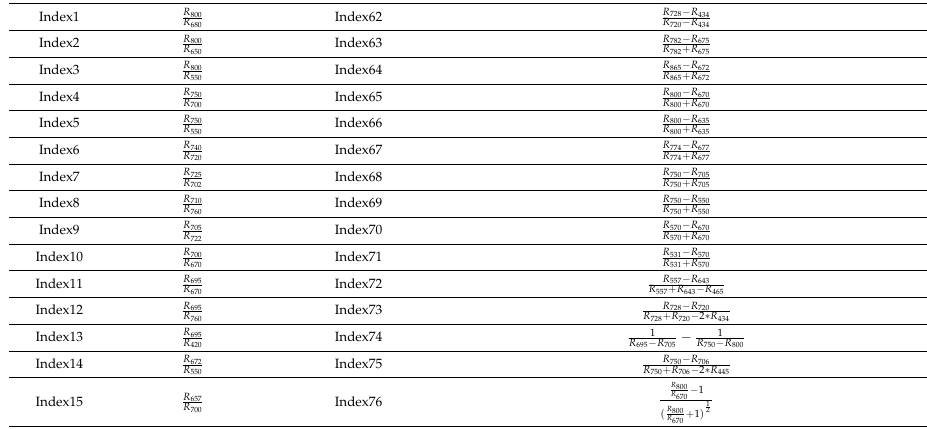
Table A1. The published empirical spectral indices [24,34,38–40] used for estimating plant species richness in Hunshandak Sandland,